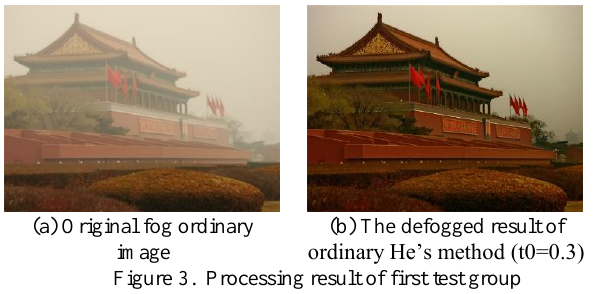
Figure 3. Processing result of first test group